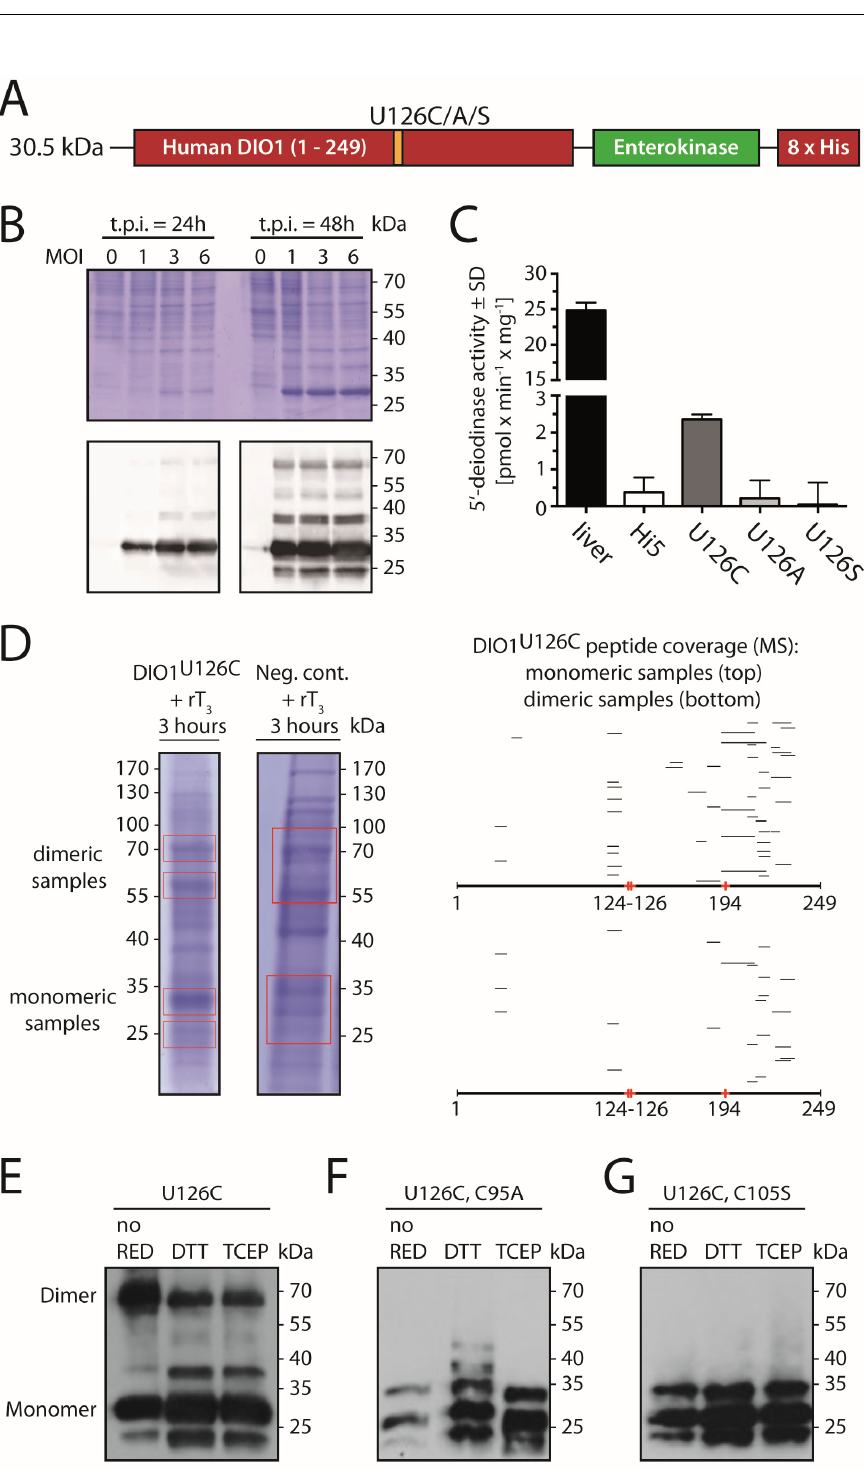
Figure 2. Biochemical characterization of recombinant human DIO1 U126C expressed in insect cells. ( A ). Construct. A C-terminal His-tag was added to the human DIO1 sequence separated by an en- terokinase cleavage site. ( B ). Electrophoretic mobility of DIO1 U126C expressed in Hi5 cells 24 h and 48 h post-infection (t.p.i.) with baculovirus. MOI, multiplicity of infection. Upper panel Coomassie-stained gel, lower panel immunodetection with anti-His-tag antibody. ( C ). Catalytic activity of recombinant DIO1 U126C compared to negative controls (DIO1 U126A , DIO1 U126S , and non- infected Hi5 cells). Mouse liver homogenate served as positive control. SD standard devia- tion. ( D ). Detection of DIO1 U126C -derived peptides by mass spectrometry. Regions encompassing “monomeric” and “dimeric” bands were cut from Coomassie-stained gels loaded with protein from DIO1 U126C -expressing cells and non-infected controls after incubation with rT3 for 3 h. Right